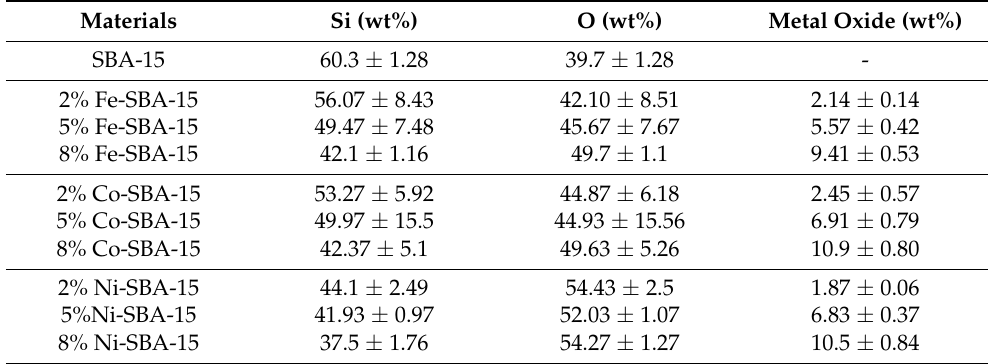
Table 2. EDS analysis of SBA-15 and Fe-, Co-, and Ni oxides-impregnated (2–8 wt%)